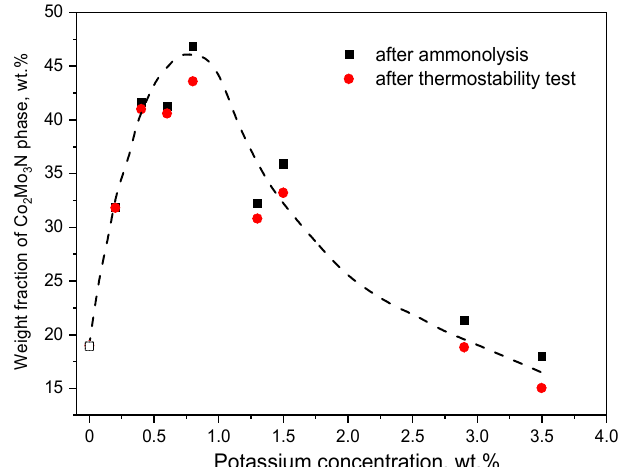
Figure 2. Weight fraction of the Co 2 Mo 3 N phase as a function of potassium concentration in COMON catalysts. A line is given for eye guidance.